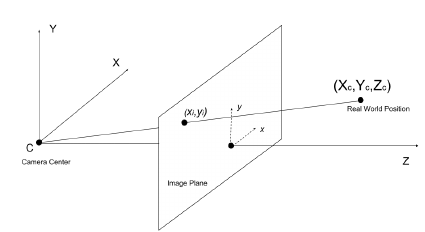
Figure 11. Relation between point coordinatein camera and imagereferencesystems